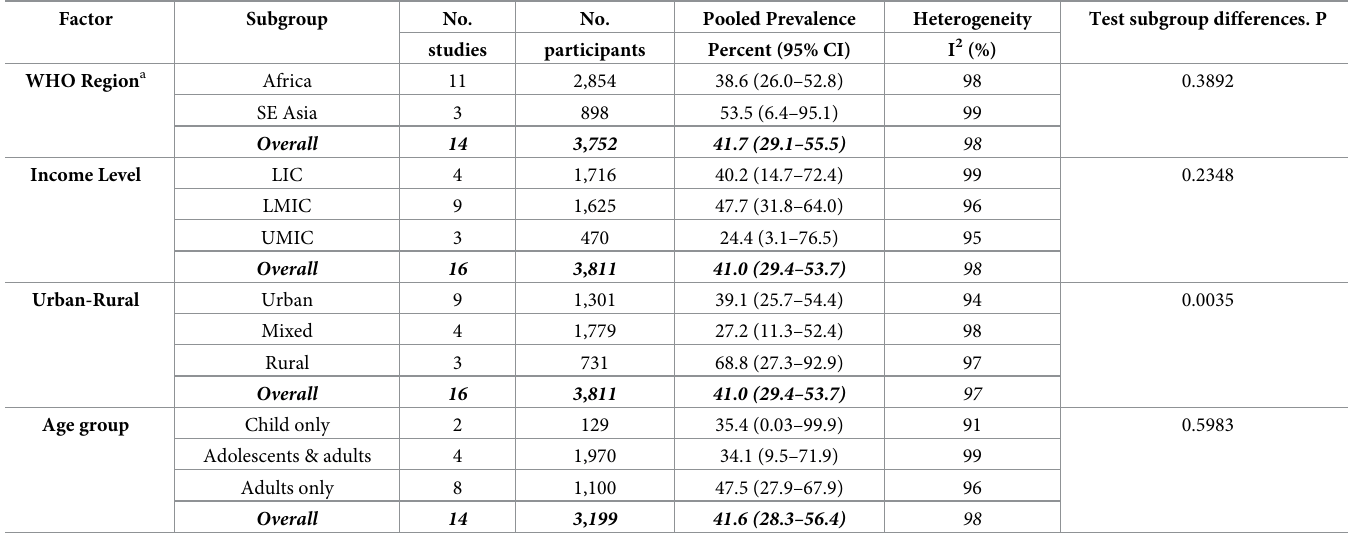
Table 3. Factors associated with persisting respiratory symptoms following TB.